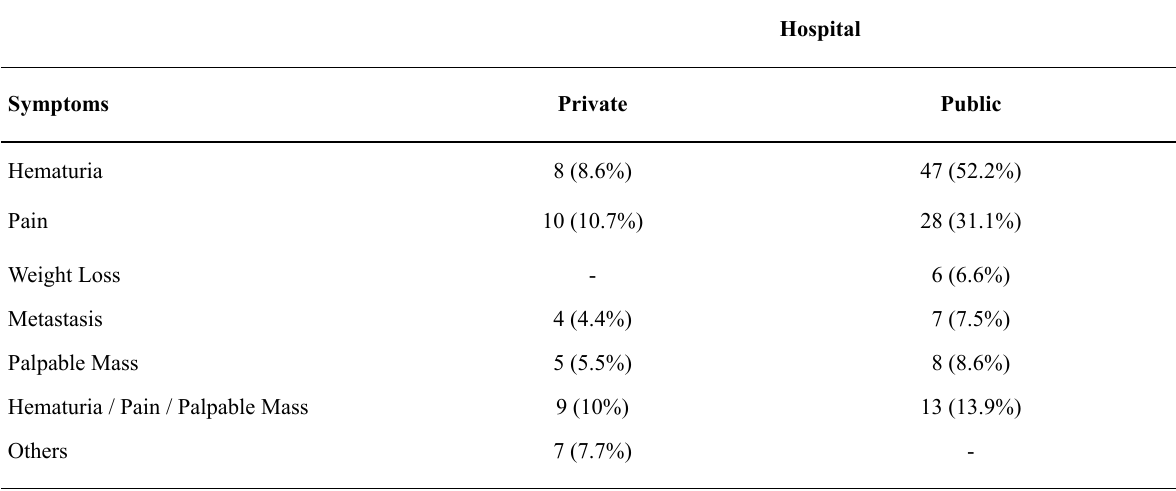
Table 3 - Symptoms at